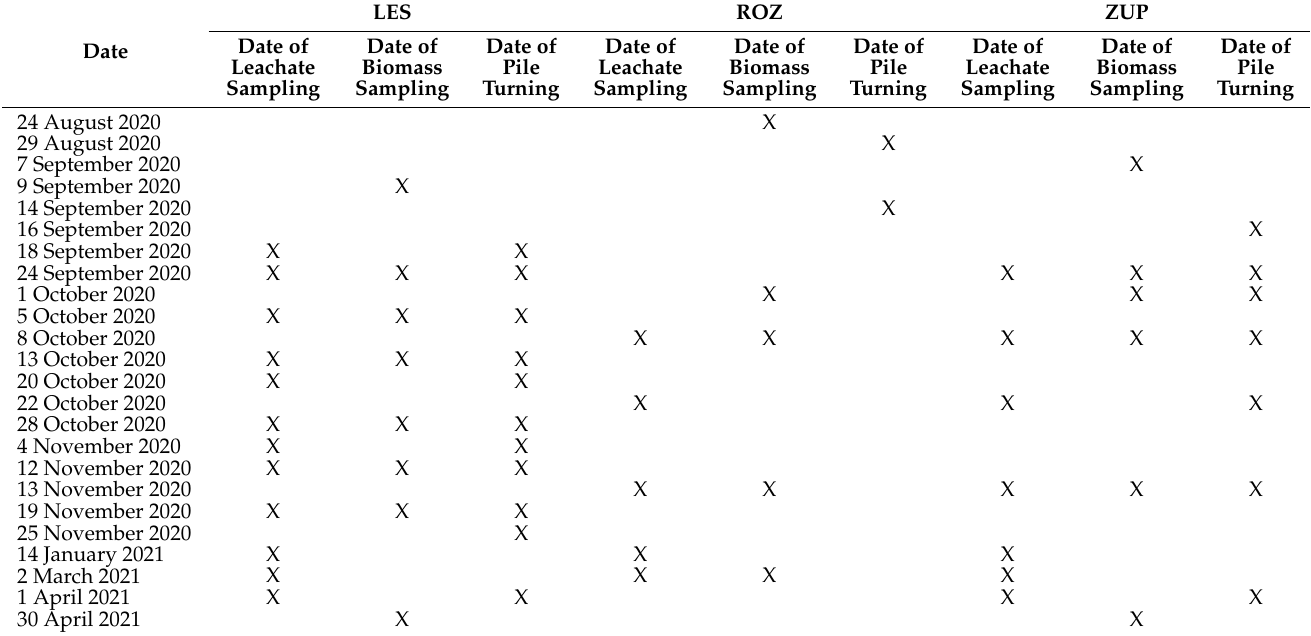
Table 2. Turning dates and sampling of the compost pile under investigation (LES, ROZ, ZUP).